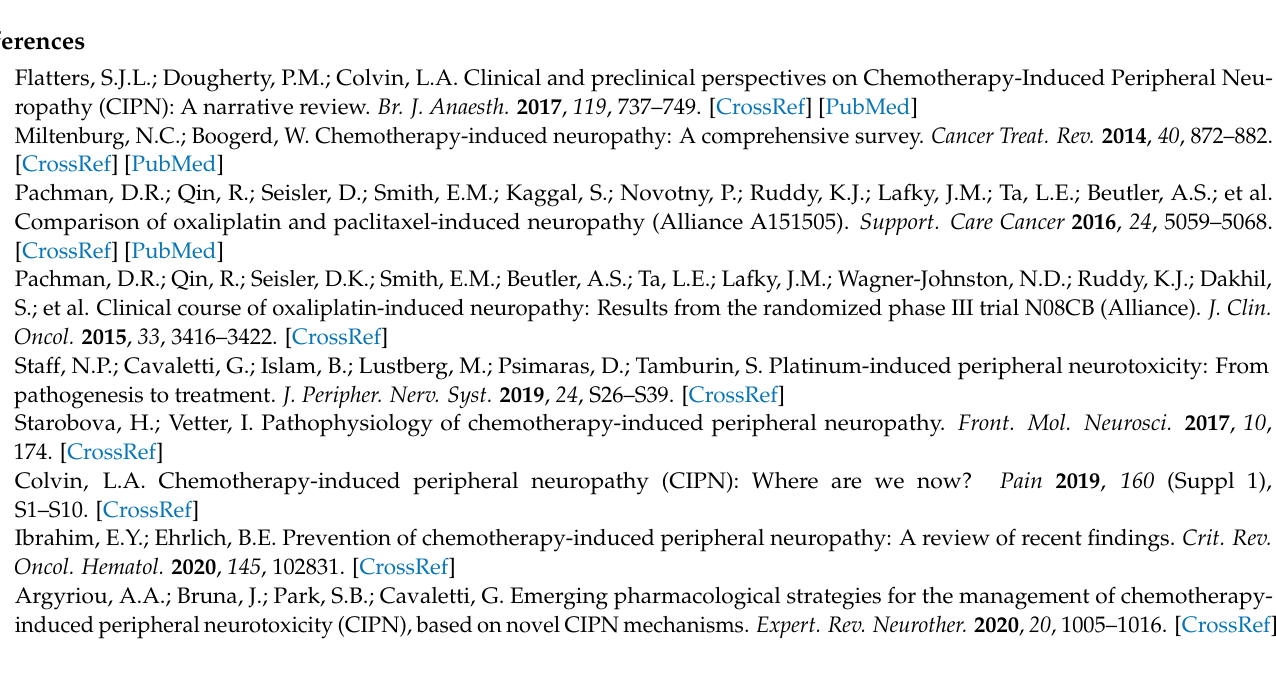
duloxetine and ambroxol on tactile allodynia in the oxaliplatin-induced neuropathic pain model, Table S2: Duration of the antiallodynic effect of single-dose minocycline and single-dose duloxetine on the pain threshold in oxaliplatin-treated mice, Table S3: Effect of minocycline, duloxetine and ambroxol on cold hyperalgesia in the oxaliplatin-induced neuropathic pain model, Table S4: Duration of the antihyperalgesic effect of single-dose minocycline and duloxetine, each used alone, on the pain threshold in oxaliplatin-treated